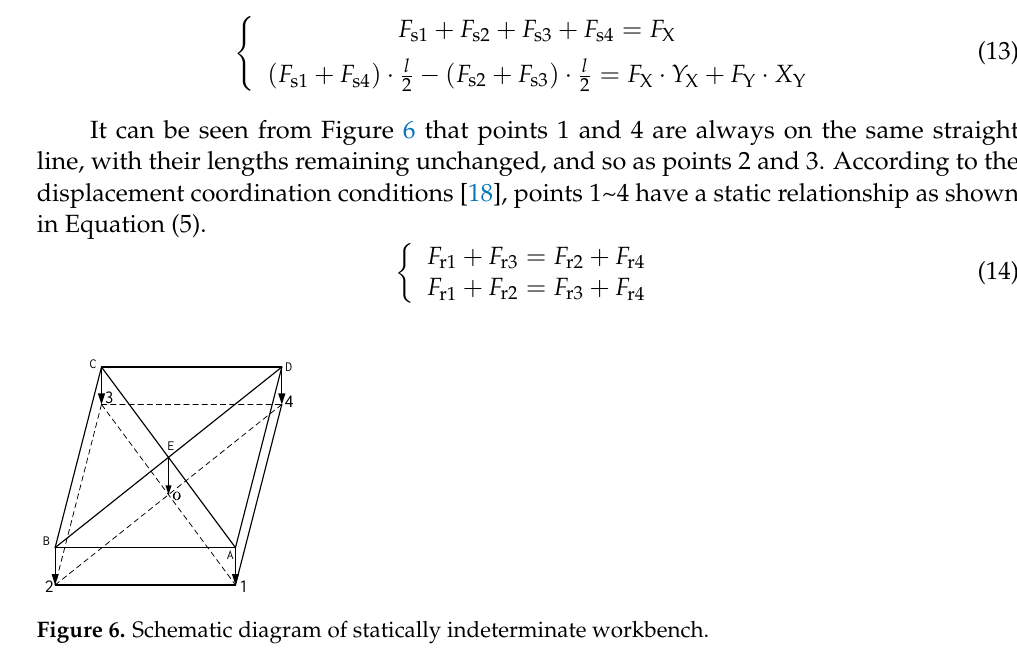
Finally, by combining Equations (13) and (14), the loads F s1 ~F s4 of each slider of the